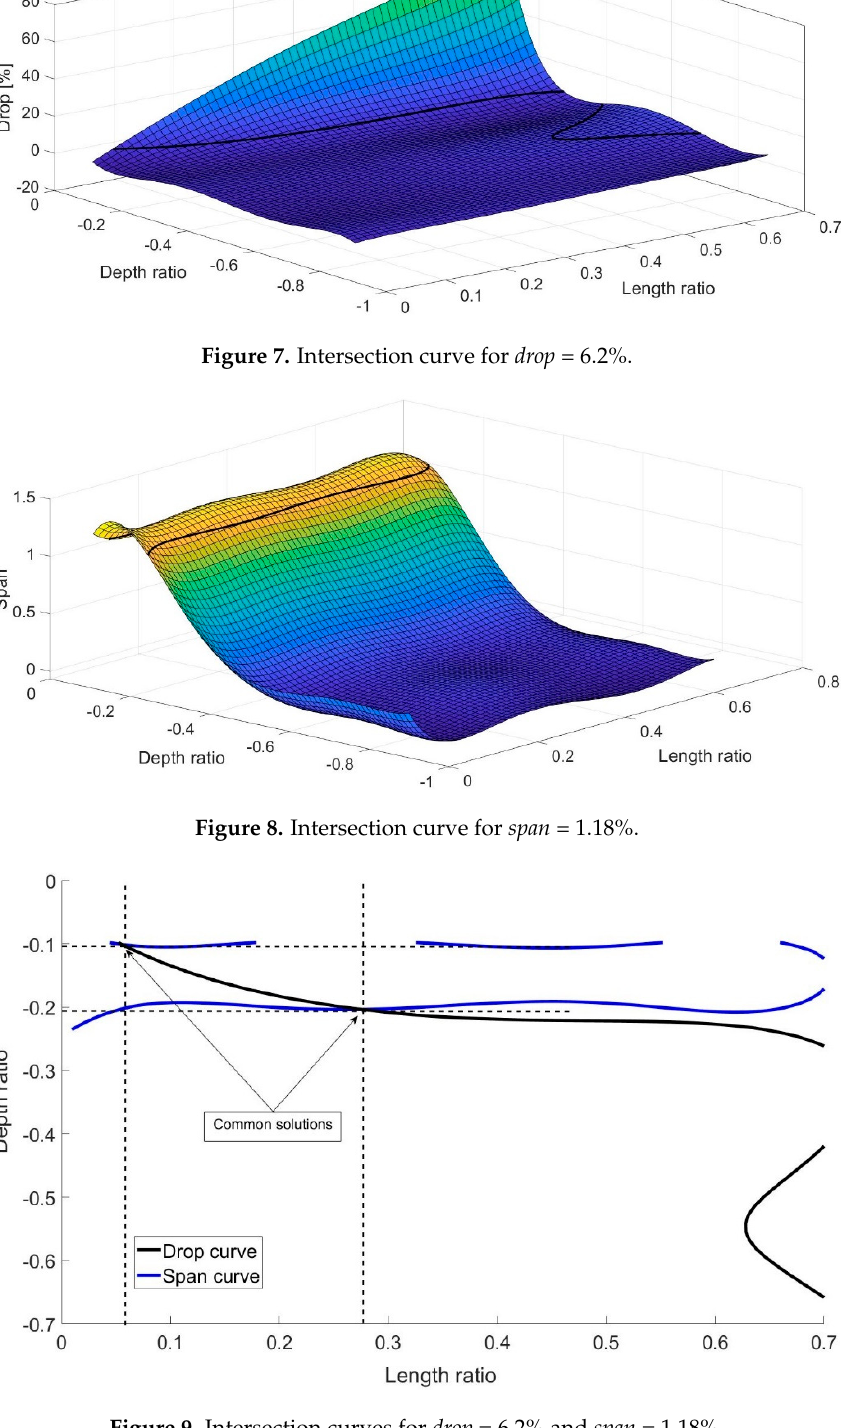
Figure 9. Intersection curves for drop = 6.2% and span = 1.18%.